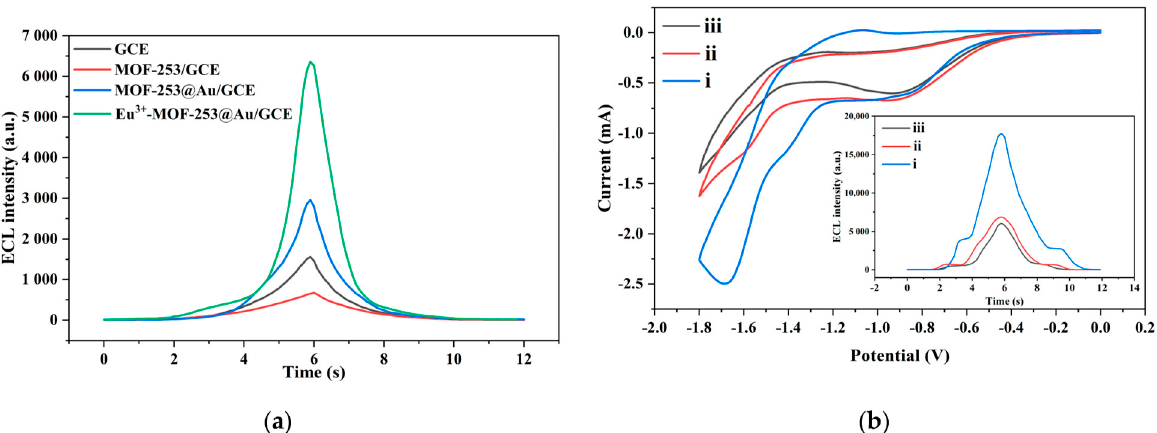
Figure 1. ( a ) ECL curves of different modified electrodes (pH 7); ( b ) CV curves of Eu 3+ -MOF- 253@Au/GCE in working solution ( ⅰ ), working solution with 100 μ g L − 1 carbaryl ( ⅱ ), and 100 μ g L − 1 1-naphthol ( ⅲ ); the insert was the corresponding ECL curves (pH 9).